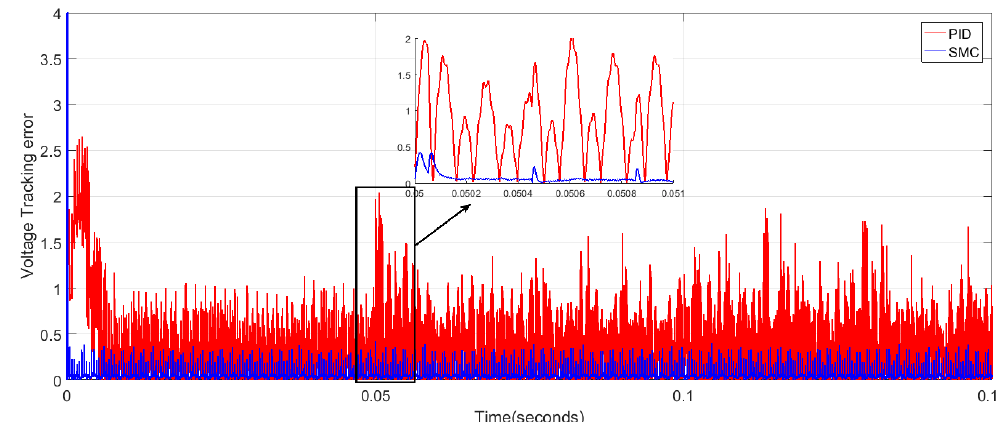
Figure 8. Reference, PID, and SMC PV power curve.